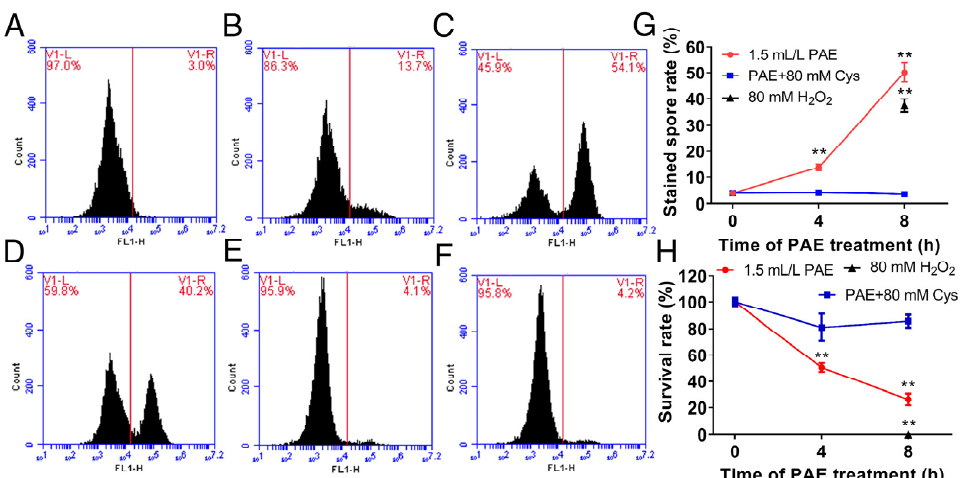
Figure 6. Effect of PAE on ROS level in F. solani detected by DCFH-DA staining. Spores were exposed to 1.5 mL/L PAE for 4 ( B ) and 8 ( C ) h, 80 mM H 2 O 2 for 8 ( D ) h, and to 1.5 mL/L PAE plus 80 mM cysteine (Cys) for 4 ( E ) and 8 ( F ) h. Spores without PAE treatment were served as control ( A ). Line charts of rate of stained spores ( G ) and survival rate of spores in every experimental group ( H ). Values are mean ± standard deviations ( n = 3). ** indicates p < 0.01 compared with the control group calculated by one-way ANOVA.